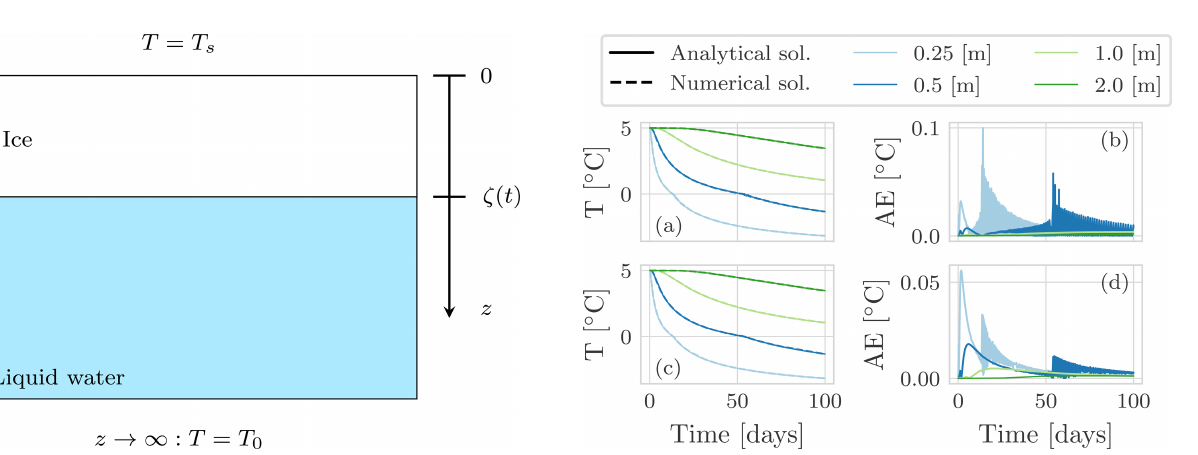
Figure 4. Panels (a) and (c) show the temperature evolution for the Neumann analytical and the numerical solution with the NCZ al- gorithm at various depths for a spatial discretization (cid:49)z = 0 . 005 m and (cid:49)z = 0 . 001m respectively. The integration time step is (cid:49)t = 3600s. Panels (b) and (d) show the absolute error.